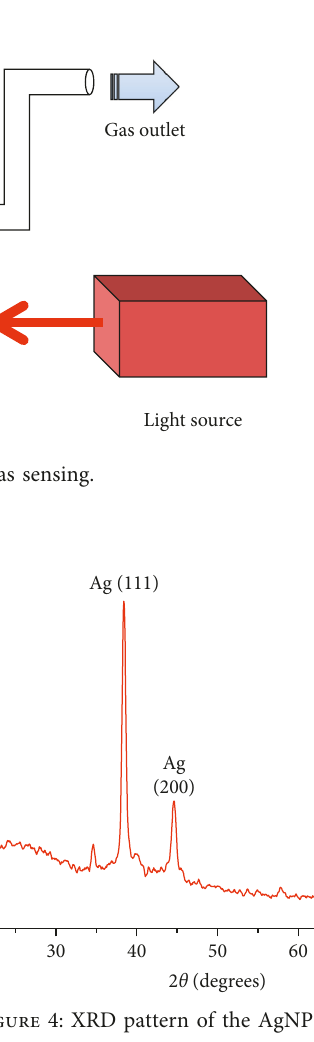
Figure 4: XRD pattern of the AgNP